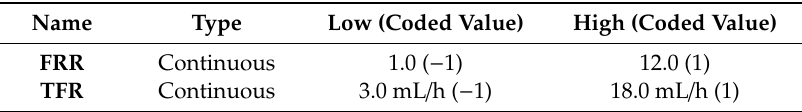
Table 1. Initial low and high experimental levels per variable. Table 1 . Initial low and high experimental levels per variable.